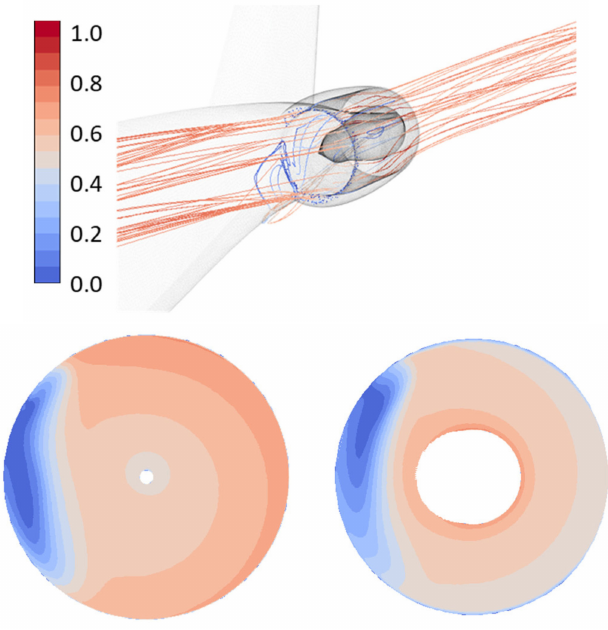
Figure 15. A zoom-in of pathlines towards the inlet of the engine ( top ) and the contours of the Mach number in the planes of interest ( bottom left : AIP, bottom right : fan inlet), results from the 3D simulation of case h / D = 0.6, e / D = 0, l a / D = l b / D =